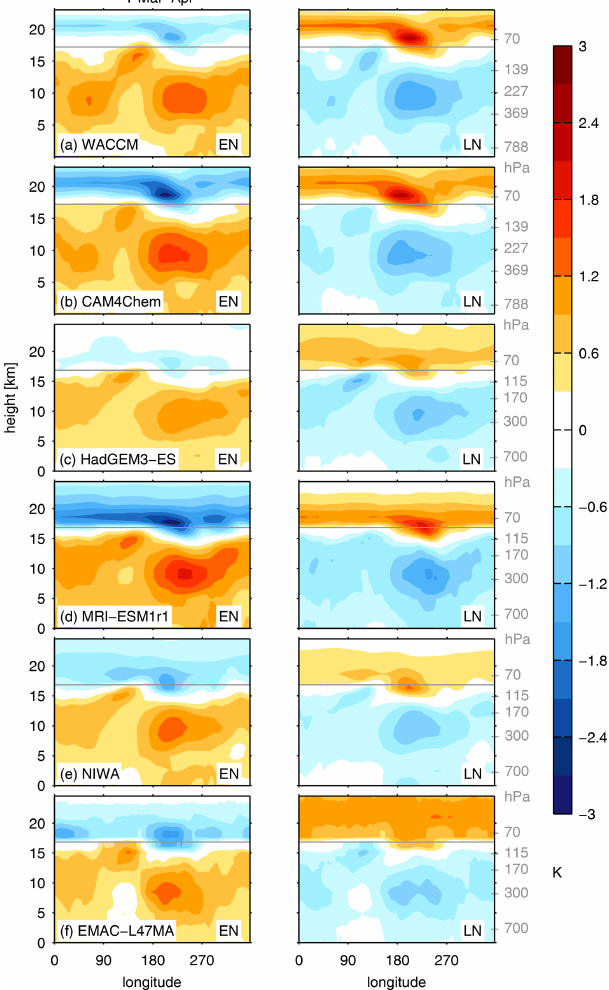
Figure 3. Longitude vs. height cross section of the 15 ◦ S–15 ◦ N temperature anomalies during (left) El Niño and (right) La Niña in each of the CCMI models. The Supplement presents map views of temperature anomalies at 70 and